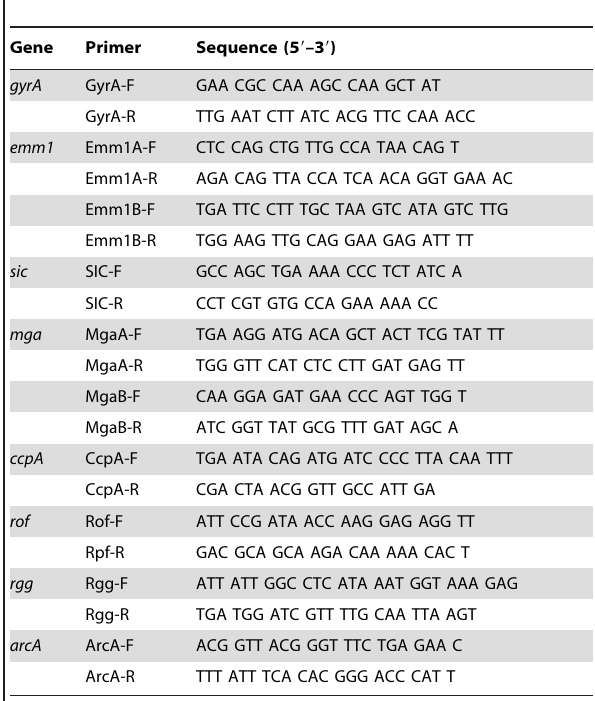
Table 1. Oligonucleotide primers used for